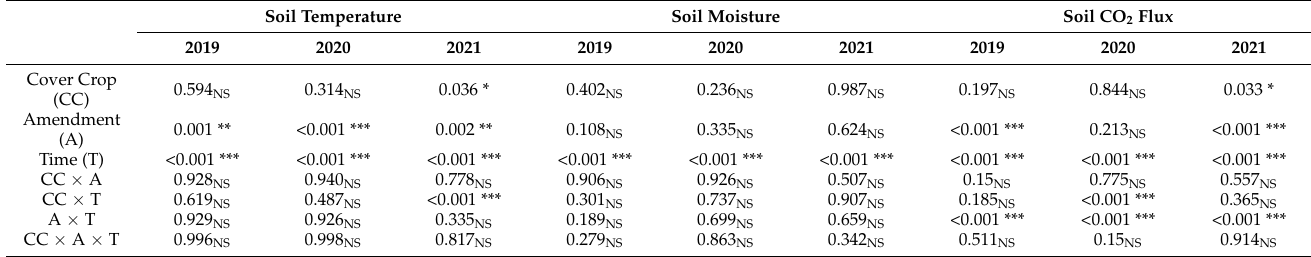
Table 4. Effects of cover crop, amendments, time and their interactions on soil parameters. The num- bers presented in the table are p values from the ANOVA test. *— p < 0.05, **— p < 0.01, ***— p < 0.001, and NS—not